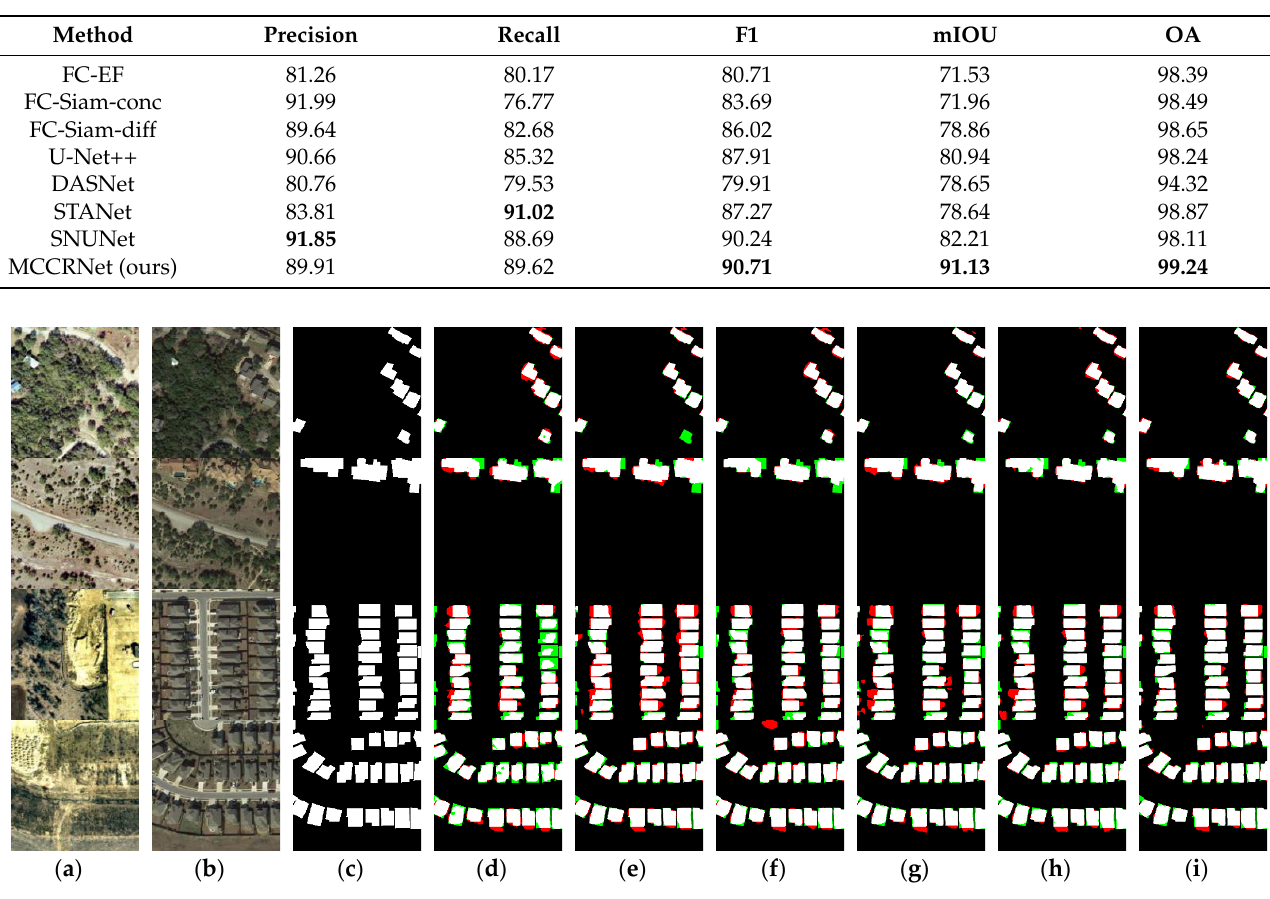
Figure 9. Visual comparison results of the LEVIR-CD dataset: ( a ) Image T1; ( b ) Image T2; ( c ) ground truth; ( d ) FC-Siam-conc; ( e ) U-Net++; ( f ) DASNet; ( g ) STANet; ( h ) SNUNet; ( i ) MCCRNet.